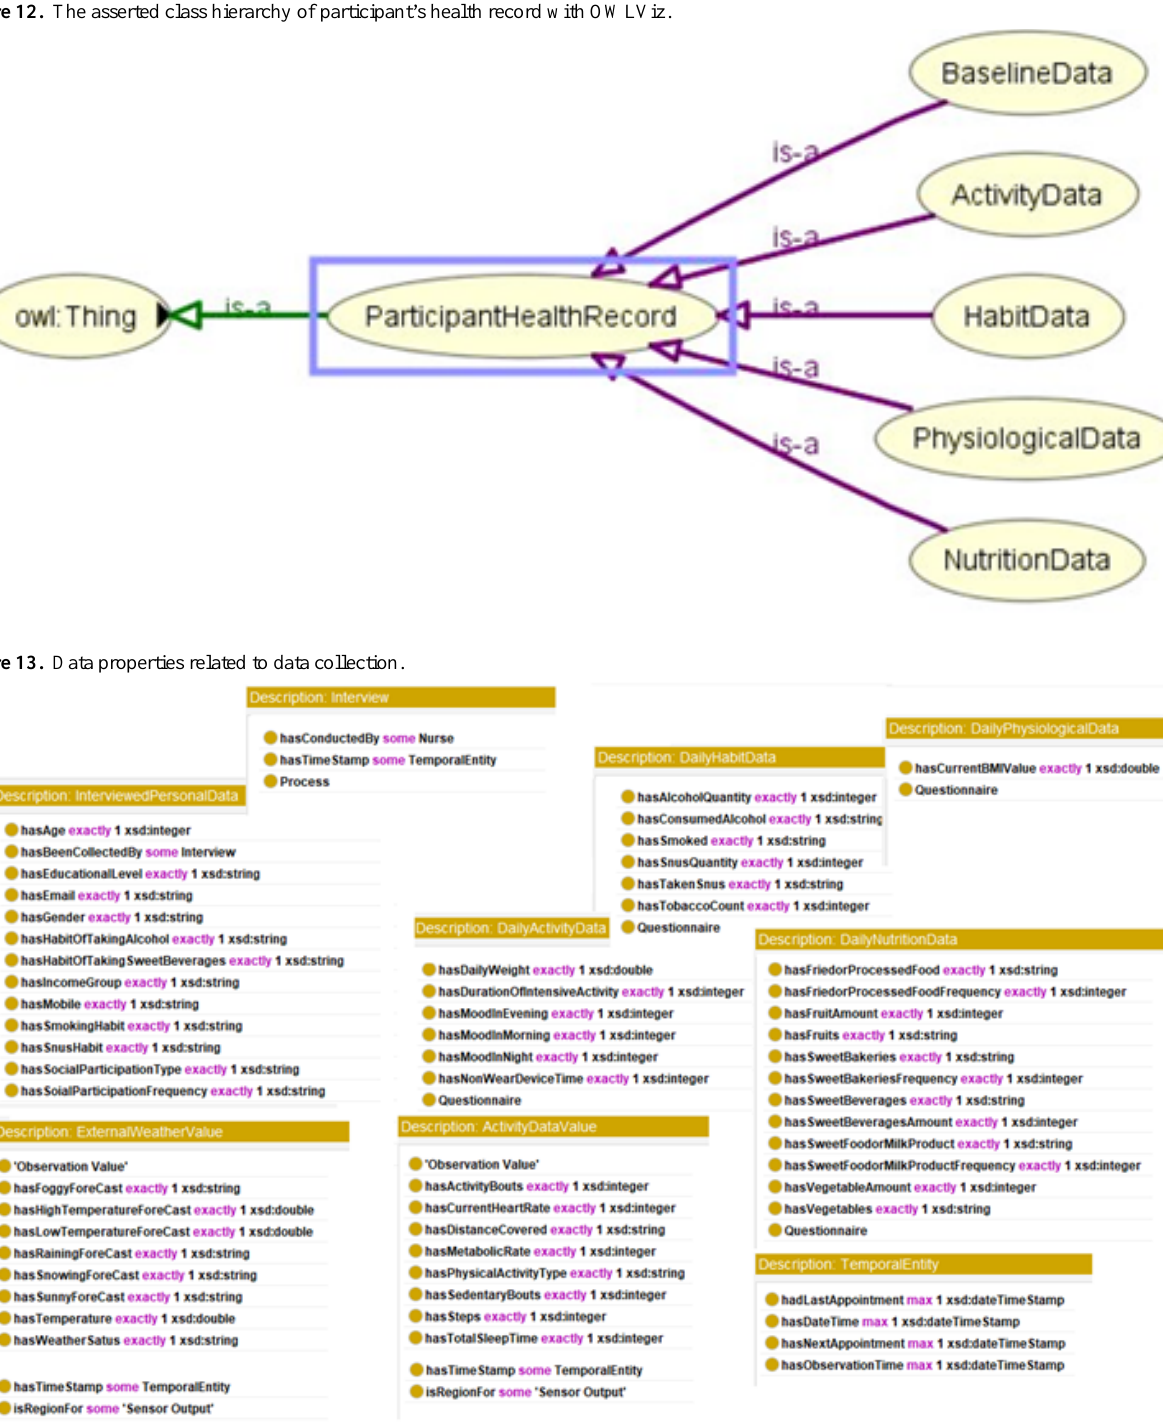
Figure 12. The asserted class hierarchy of participant’s health record with OWLViz.